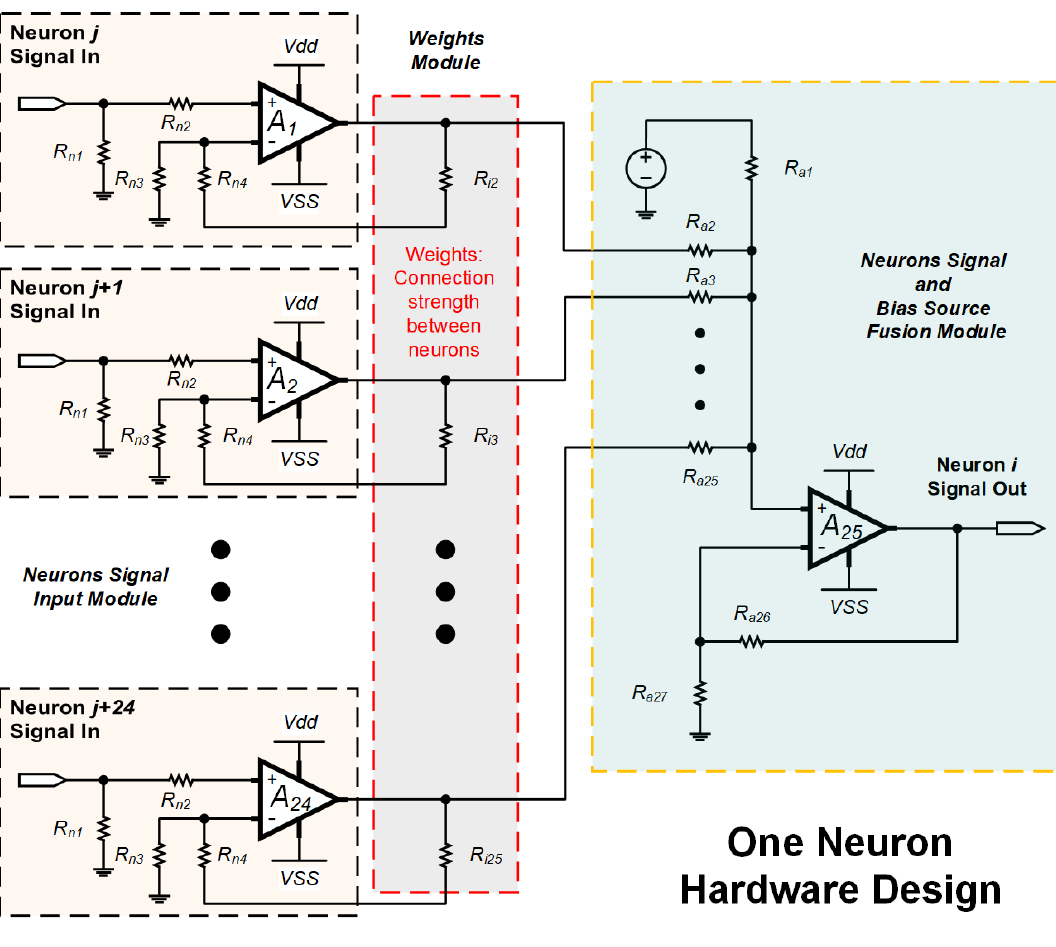
Figure 4. The Hopfield neural network of one Neuron circuit design.